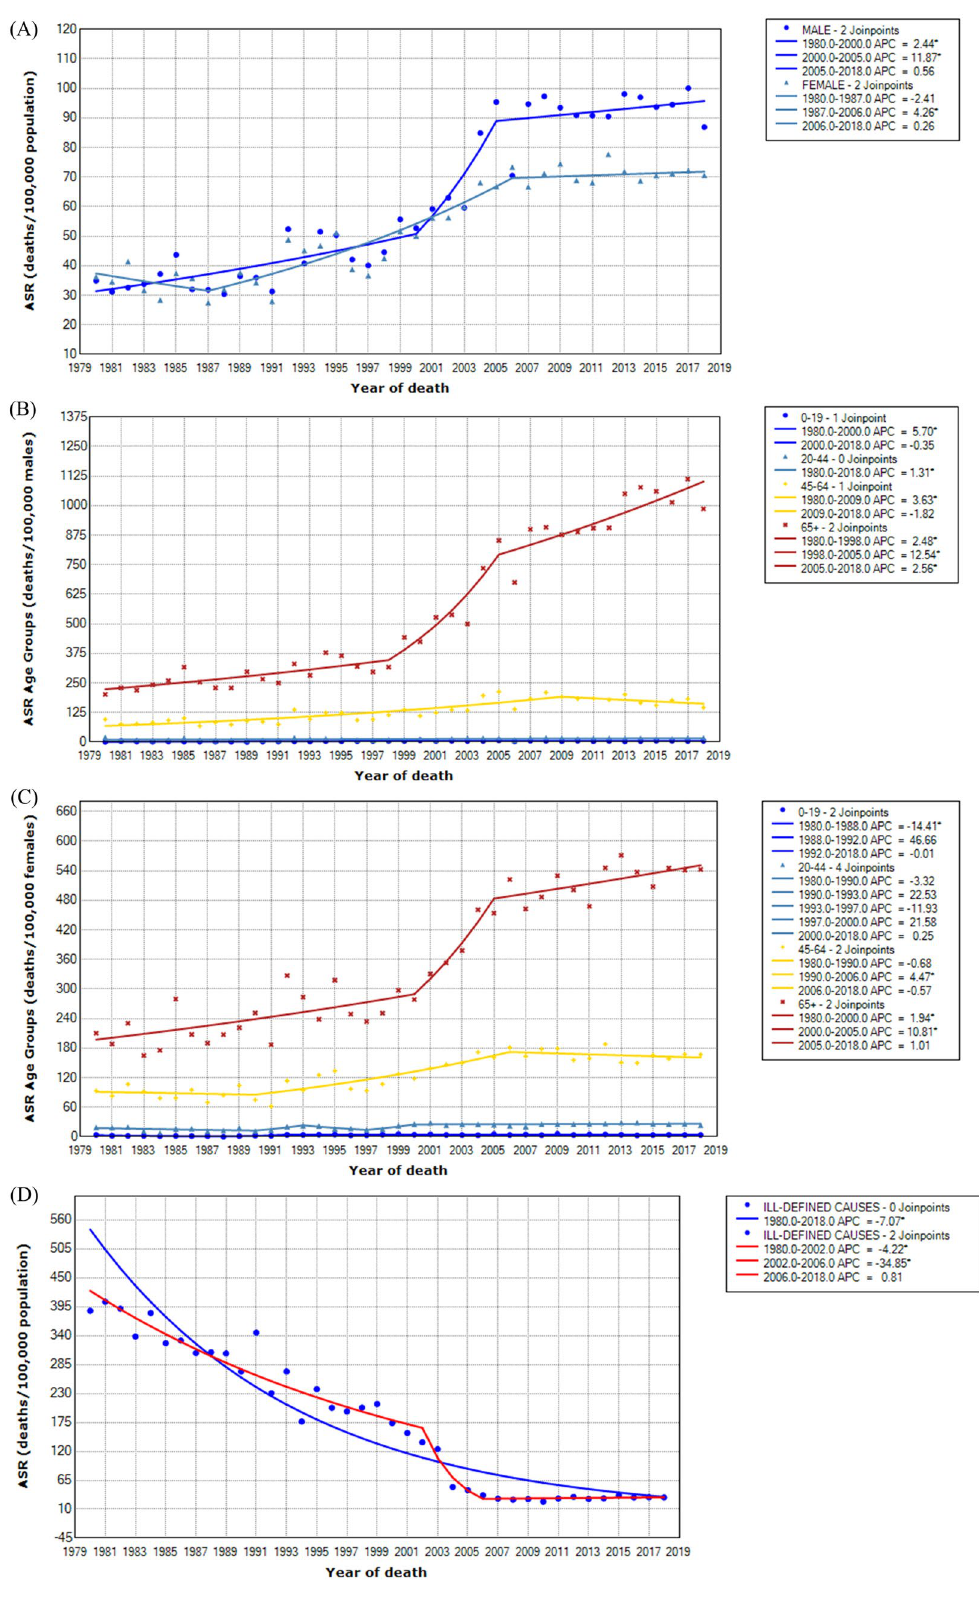
Figure 1. Time trends of cancer mortality for age-standardized rates (ASR) for all ages and sites in both sexes ( A ), for specific age groups in males ( B ) and in females ( C ) and for ill-defined causes of death ( D